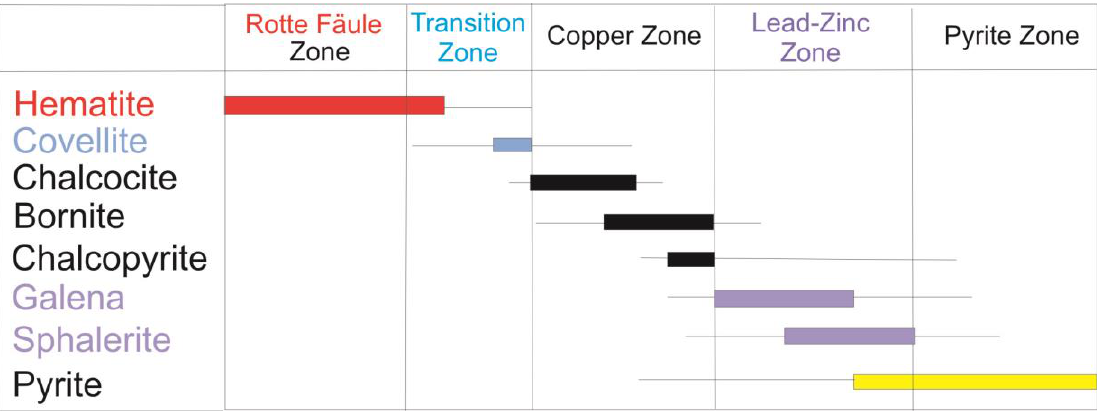
Figure 9. Simplified paragenetic succession of ore mineralization from the Cu-Ag Kupferschiefer deposits in Poland, modified after [53].